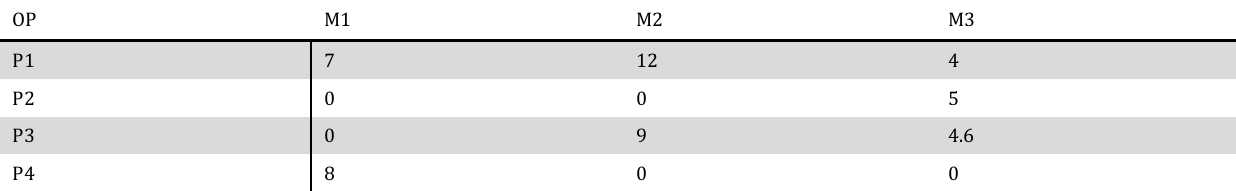
Operational cost of using each machine